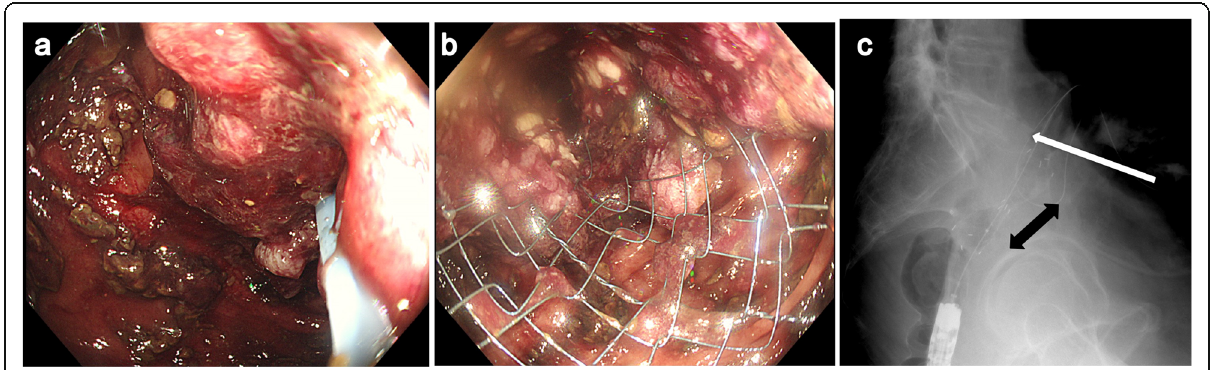
Fig. 2 a Colonoscopy showing bowel obstruction with a malignant rectal tumor. b Self-expanding metallic stent placement through the malignant rectal obstruction using endoscopy. c Fluoroscopy showing a 2.8-cm constricted area due to tumor (black double-headed arrow) which of the upper end located at the anal side of the promontory (white long